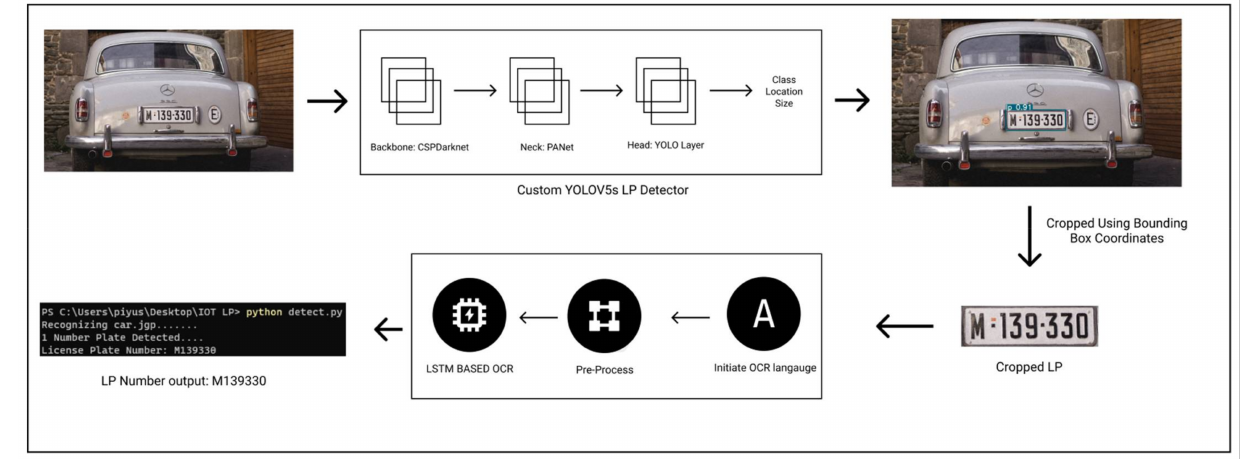
Figure 4. Overview of the methodology.